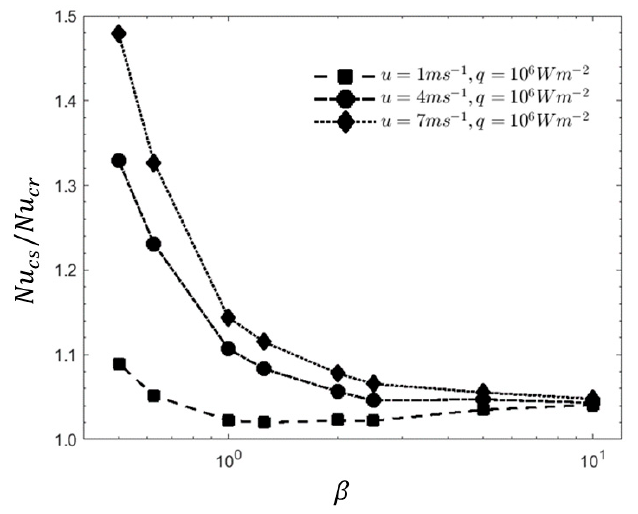
Figure 5. Nu cs /Nu cr against β .